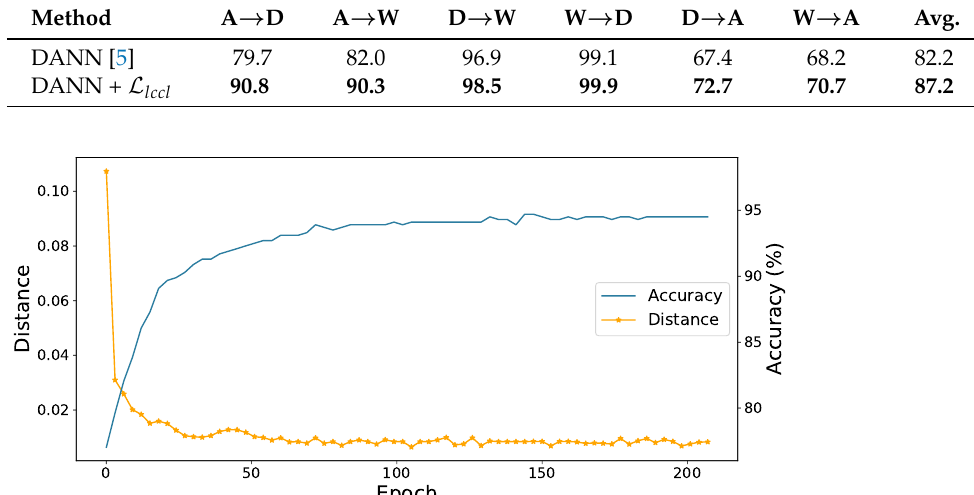
Table 5. The benefits of our approach to DANN.